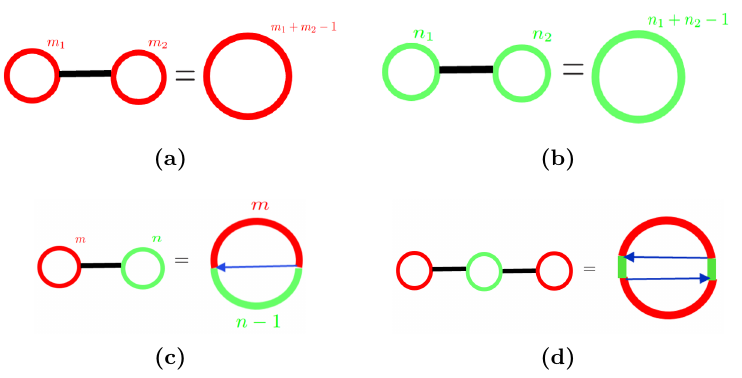
Figure 1. Diagrams of tree operators from ref. [23].